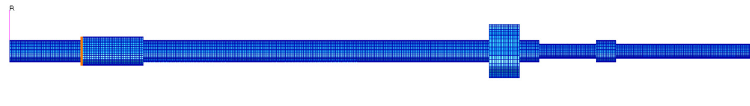
Figure 9. Axial constraints.